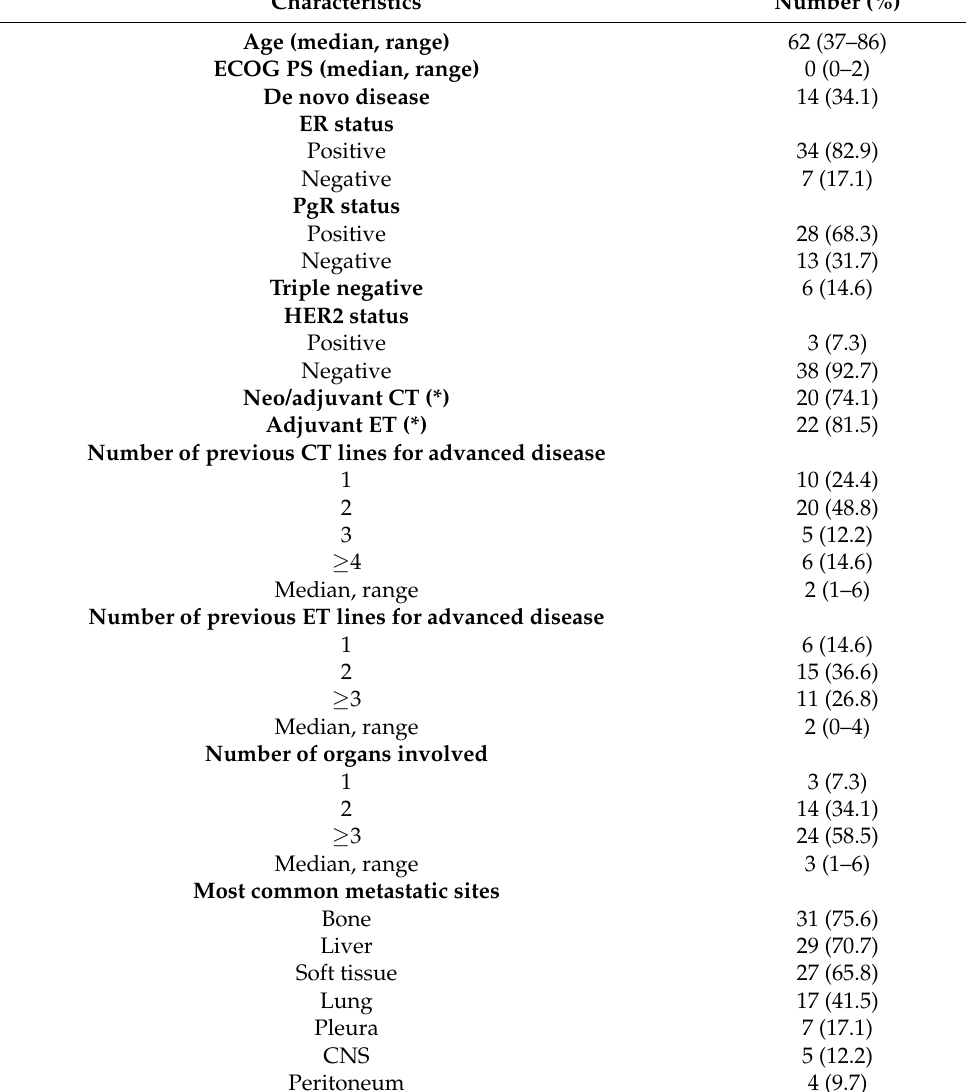
Table 1. Patients’